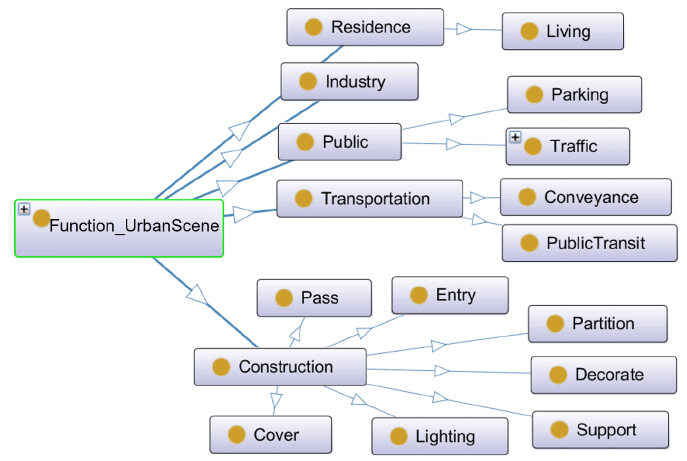
Figure 3. Classification of concepts according to functionality perspective.